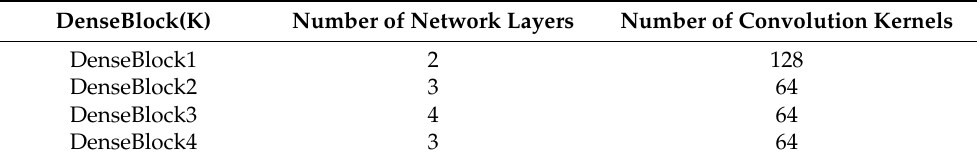
Table 1. DenseBlock